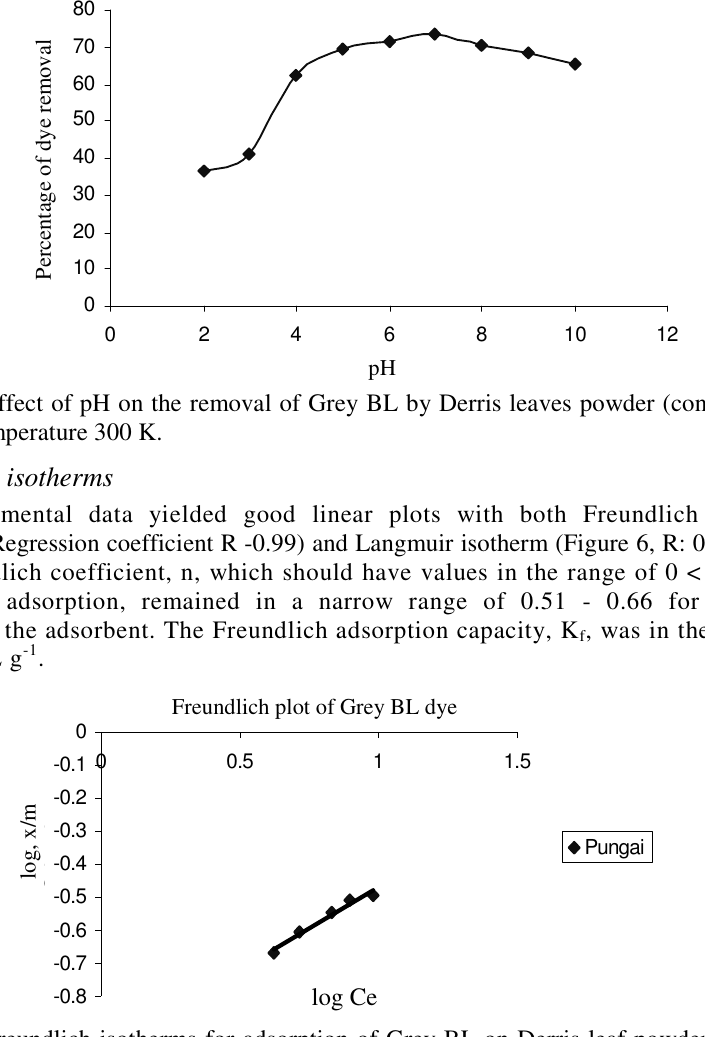
Figure 5. Freundlich isotherms for adsorption of Grey BL on Derris leaf powder at 300 K with dye concentration of 50 mg/L and agitation time 5 h